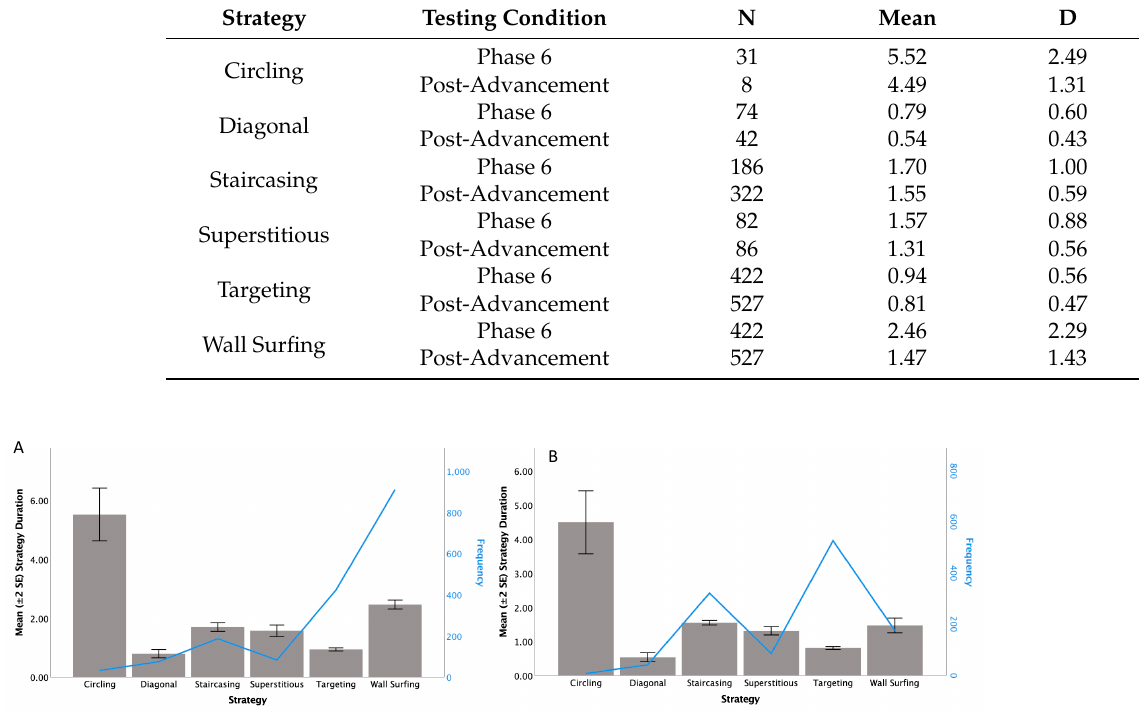
Figure 5. Mean (±2 SE) strategy duration and frequency of use of strategies for testing conditions: ( A ) Phase 6 and ( B ) Post-Advancement. (±2 SE).